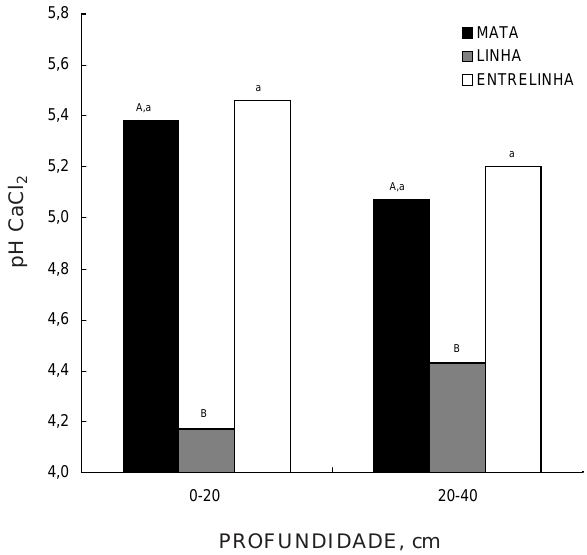
PROFUNDIDADE, Figura 1. Valores médios de pH em CaCl , nas 2 profundidades de 0-20 e 20-40 cm, para os três locais estudados. As letras maiúsculas comparam as áreas sob mata e linha da cultura, a 5% pelo teste t. As letras minúsculas comparam a mata e a entrelinha da cultura, a 5% pelo teste t.